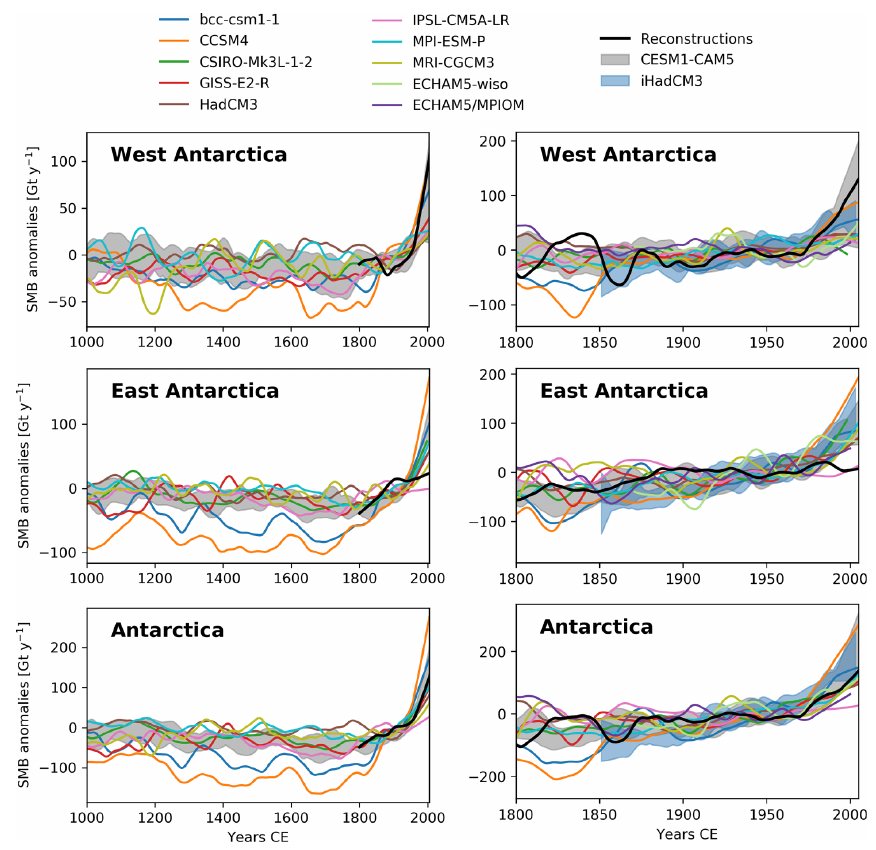
Figure 2. Surface mass balance anomalies (Gtyr − 1 ) simulated by the GCMs (Table A1) and snow accumulation reconstructions (Thomas et al., 2017) from 1000 to 2005 and from 1800 to 2005 for West Antarctica, East Antarctica, and Antarctica as a whole. Anomalies are relative to the 1871–2000 period. The shaded area corresponds to the range of the CESM1–CAM5 simulations. For visibility, data have been smoothed with a 100-year moving average for the last millennium and a 30-year moving average for the last 200 years. The equivalent for the seven regions is given in Fig. S1 in the Supplement.